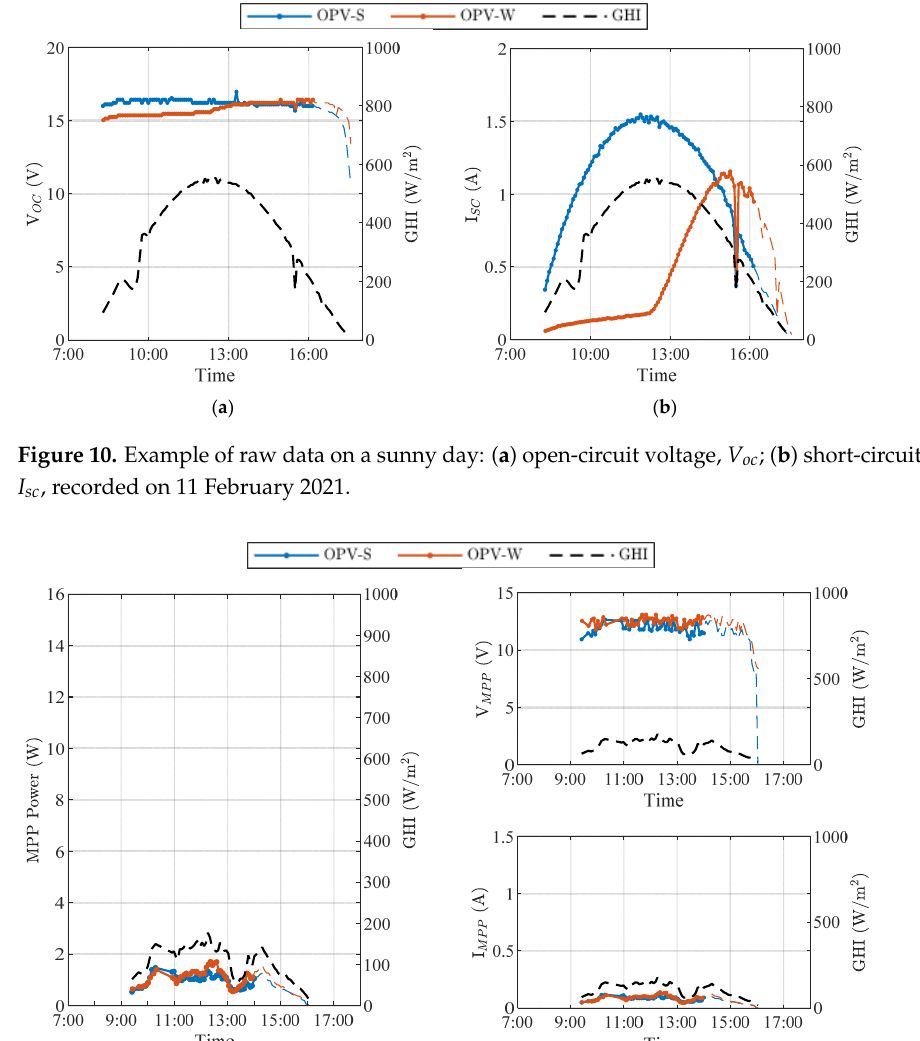
and I mpp , recorded on 11 February 2021.